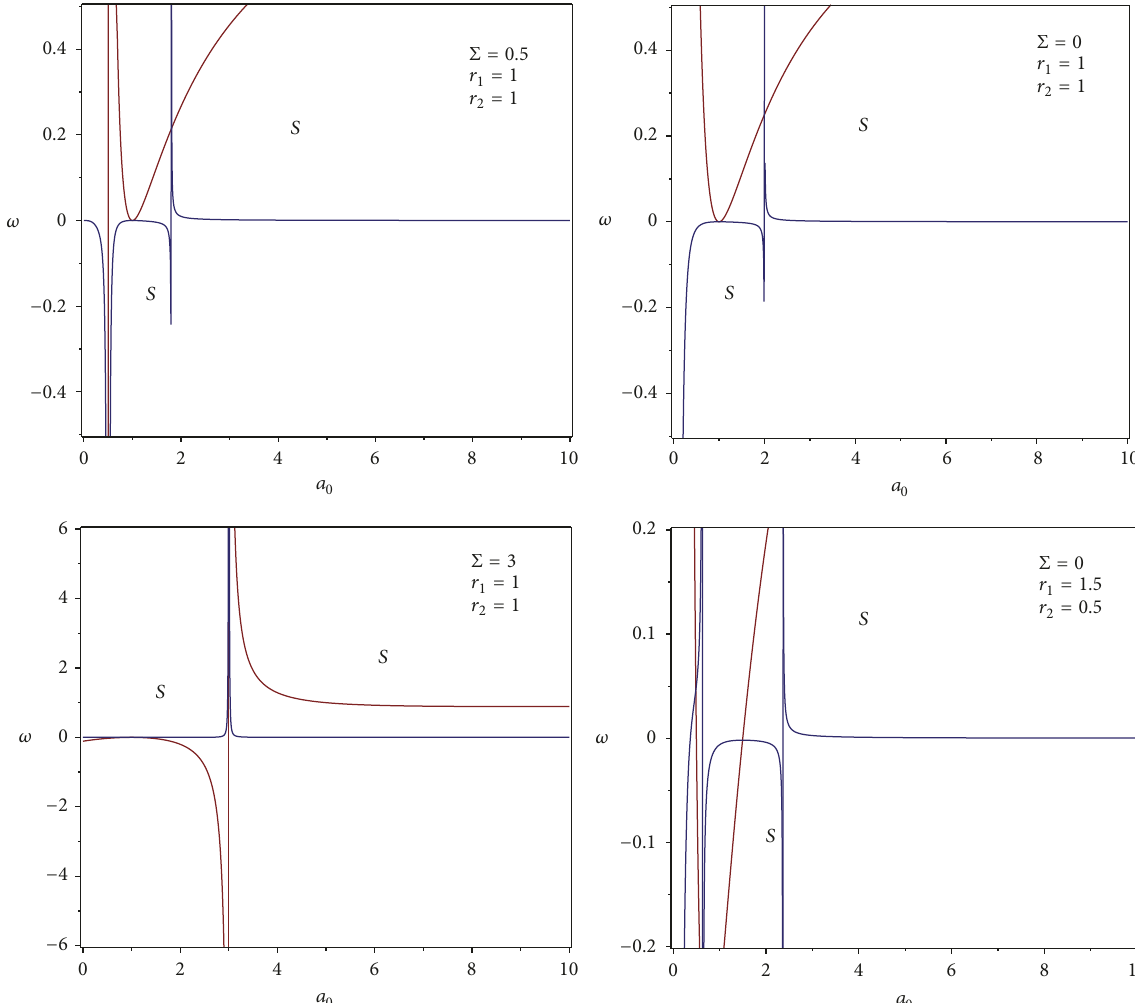
Figure 2: Stability regions of DTSW in terms of 𝜔 as a function of the throat 𝑎 0 for different values of Σ , 𝑟 1 , and 𝑟 2